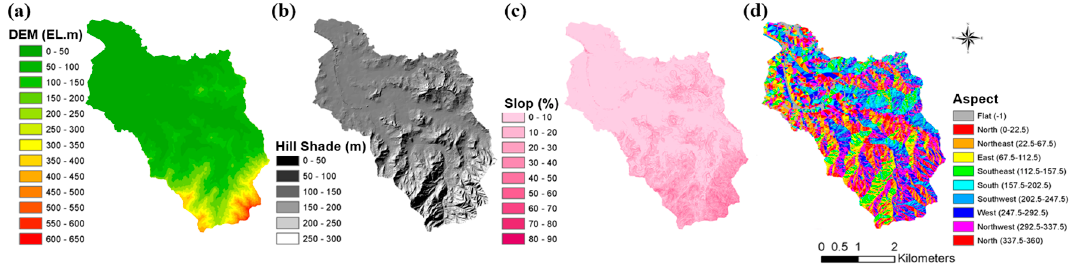
Figure 7. Information on the target watershed: ( a ) Digital elevation model (DEM), ( b ) Hill shade, ( c ) Slope, and ( d ) Aspect of flow direction.